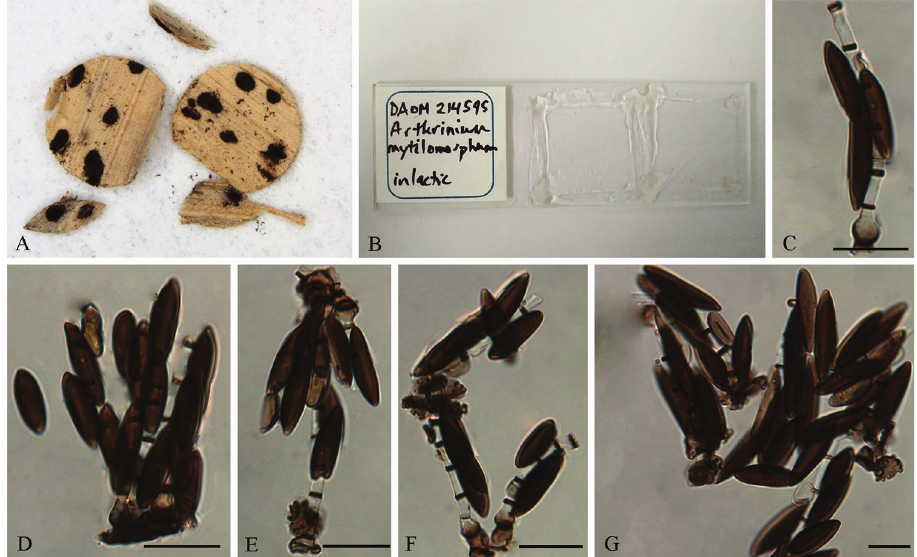
Figure 11. Arthrinium mytilomorphum (from holotype DAOM 214595) A–B Overview of the type specimen C–F Conidiogenous cells giving rise to conidia G Conidia. Scale bars = 10